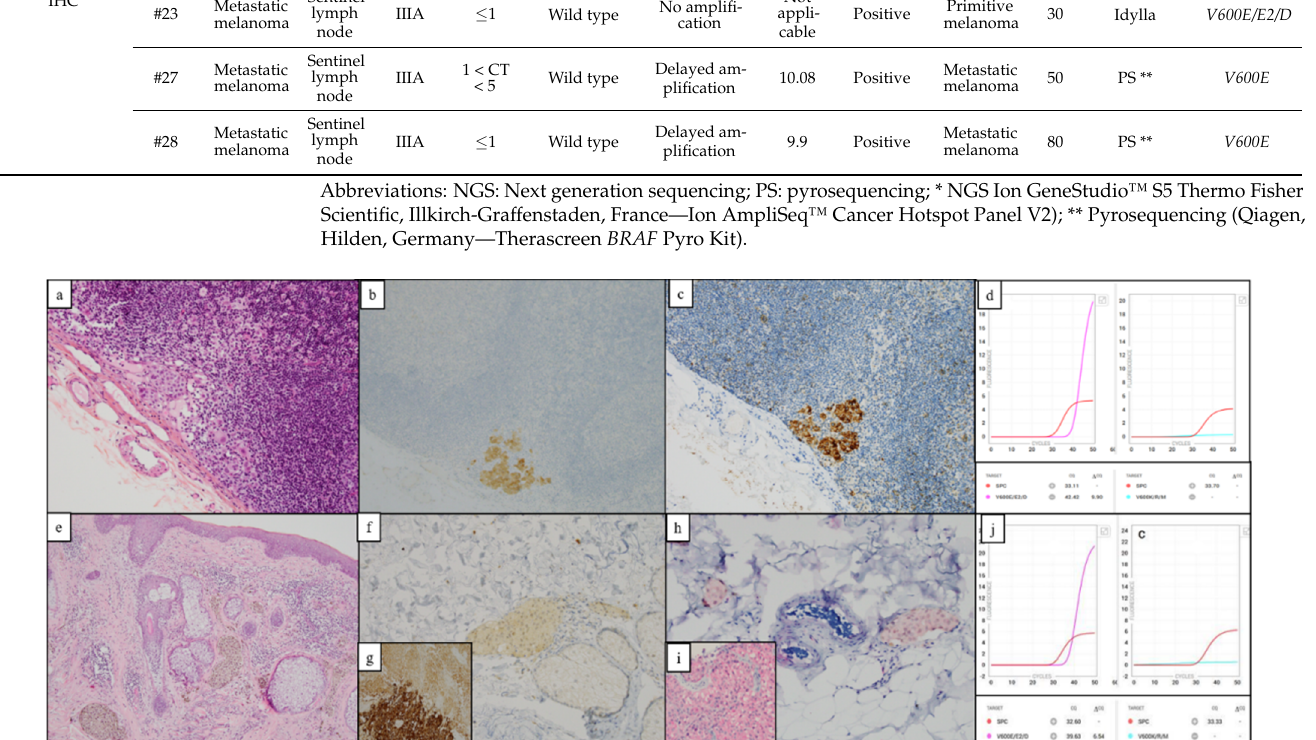
Table 4. Contribution of the Idylla Explore tool for cases at risk of false negative results.